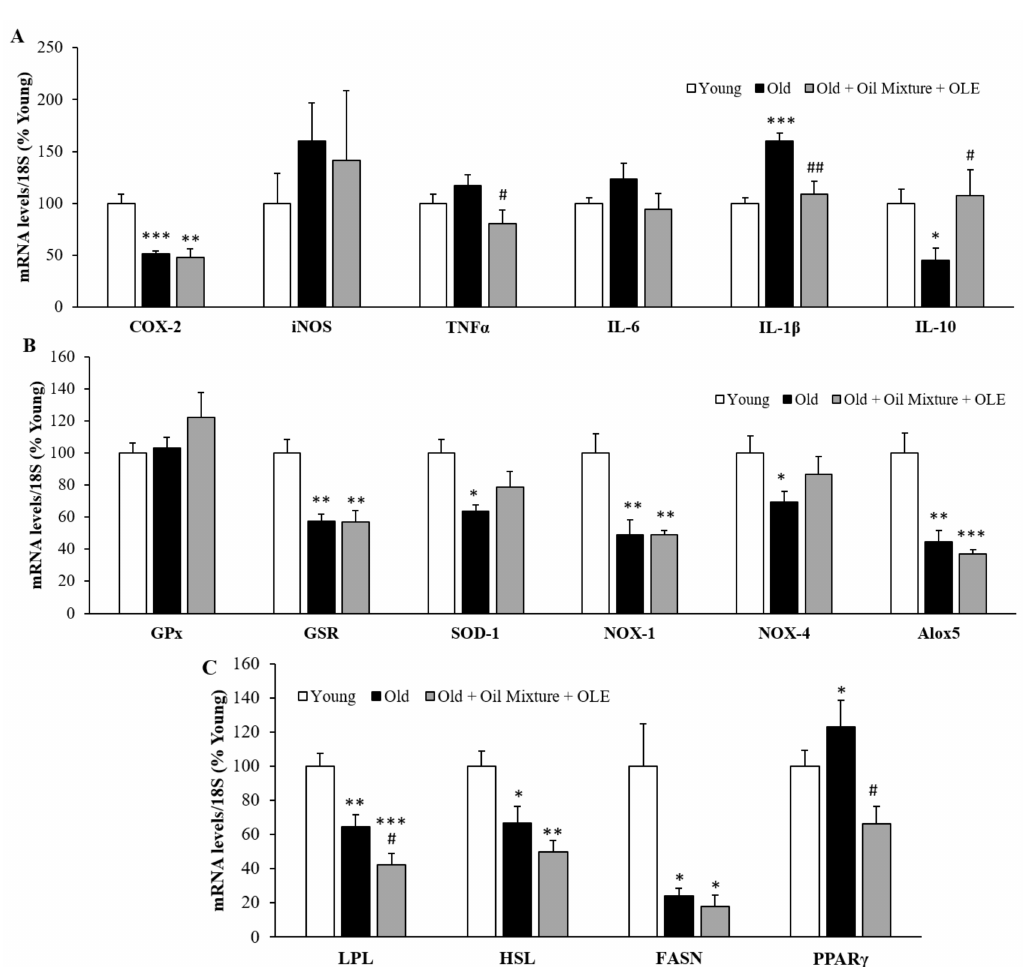
Figure 6. Epididymal adipose tissue mRNA concentrations of cyclooxigenase-2, inducible Nitric Oxide Synthase, Tumor Necrosis Factor α and Interleukin 6, 1 β and 10 ( A ); and of Glutathione Peroxidase and Reductase, Super Oxide Dismutase 1, NADPH oxidases 1 and 4 and Lipoxygenase ( B ); and of Lipoprotein lipase, Hormone-sensitive lipase, Fatty acid synthase and Peroxisome proliferator activated receptor γ ( C ) of young rats, old rats and old rats treated 21 days with the Oil Mixture and the OLE. Values are represented as mean ± SEM. * p < 0.05 vs. Young; ** p < 0.01 vs. Young; *** p < 0.001 vs. Young; # p < 0.05 vs. Old; ## p < 0.05 vs.